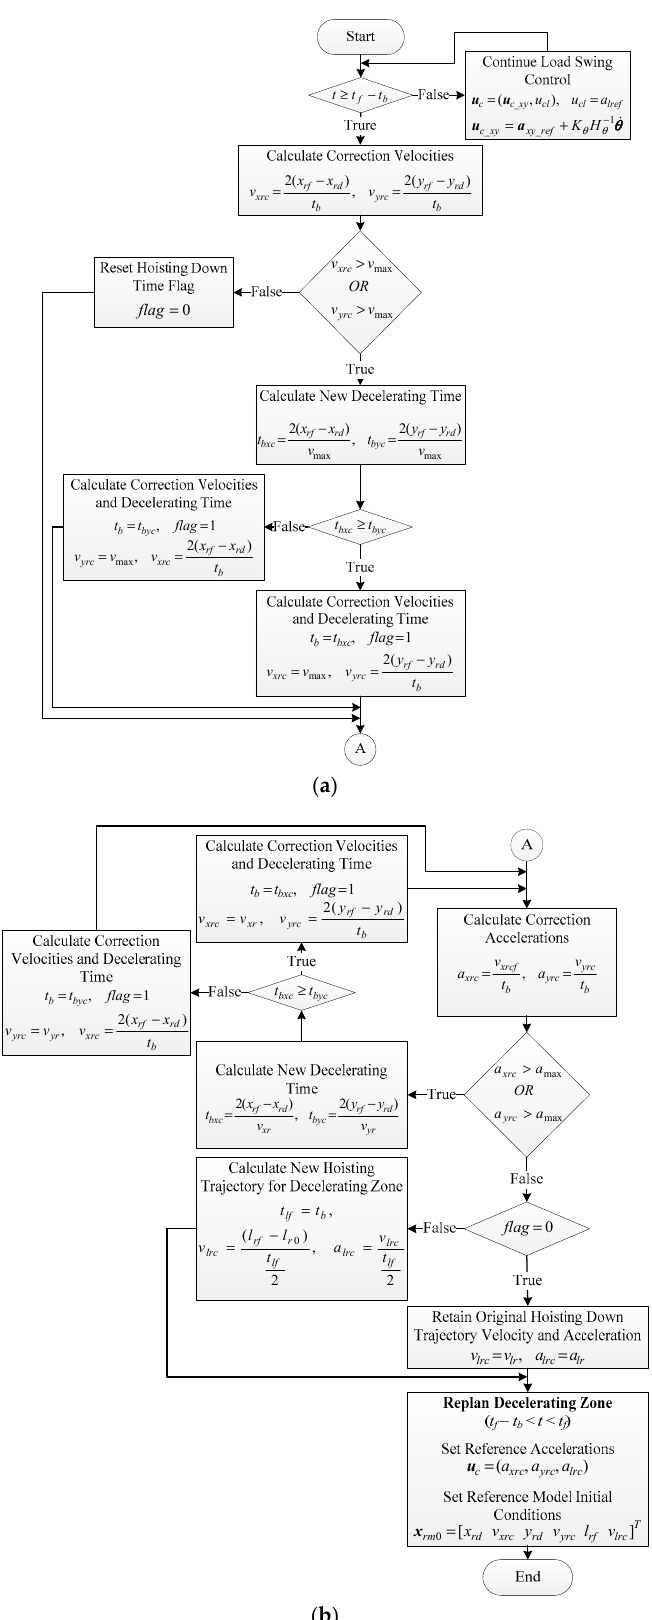
Figure 6. The proposed motion planning flowchart. ( a ) Calculation of correction velocities; ( b ) Calculation of correction acceleration, recalculation of correction velocities, hoisting velocity, and acceleration if decelerating time is extended.